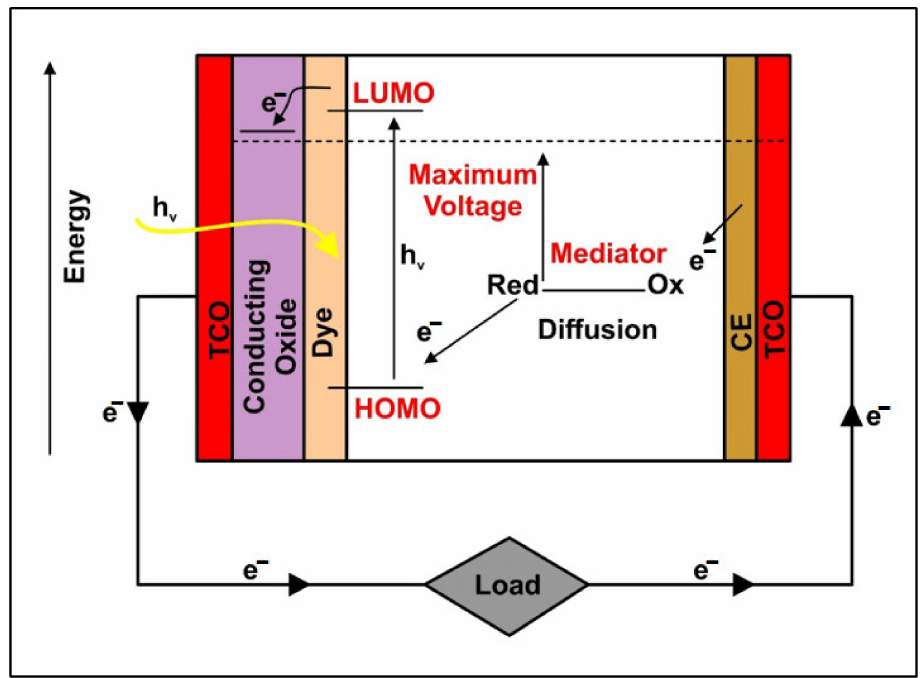
Figure 3. Schematic representation of the DSSC working principle with indications of electron movements from the HOMO to LUMO regions of the cell and passing through the external circuitry system for accumulation at the